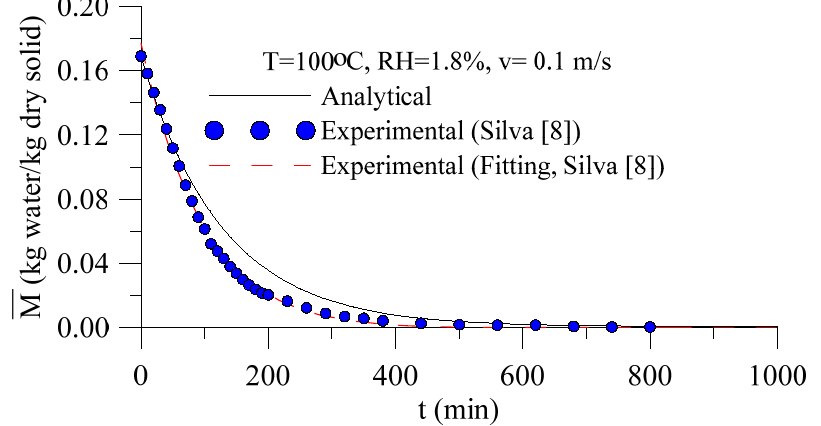
Figure 5. Comparison between the predicted and experimental average moisture content during the drying process of industrial hollow ceramic bricks.